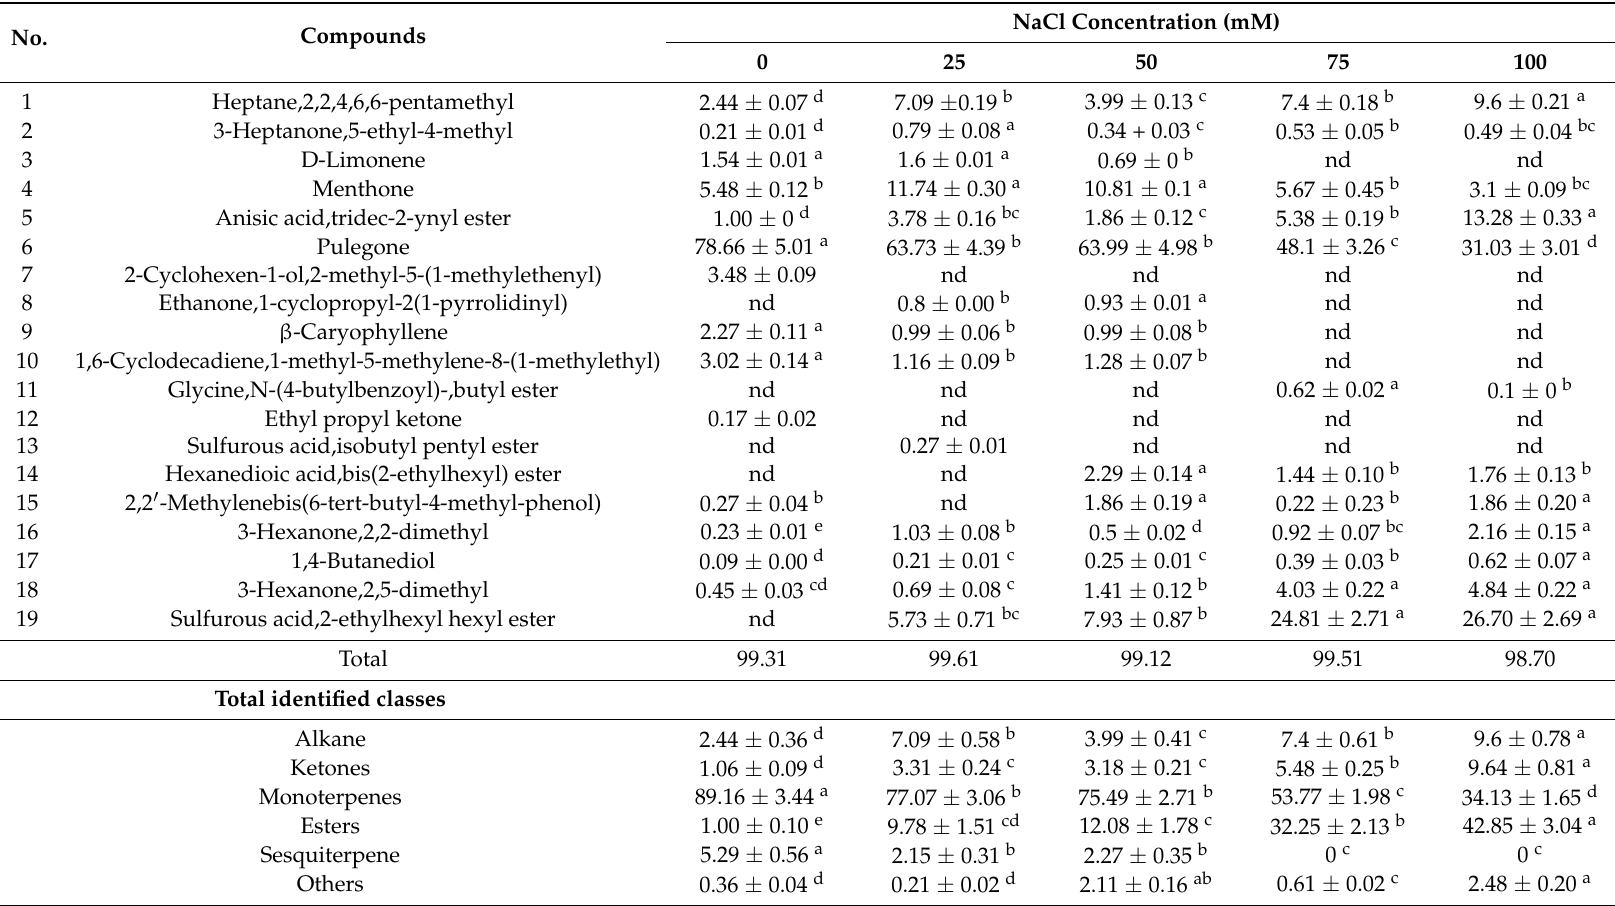
Table 2. Compositions of glandular trichome volatile exudates in S. tenuifolia and changes of their relative percentage (%) as affected by salt stress.